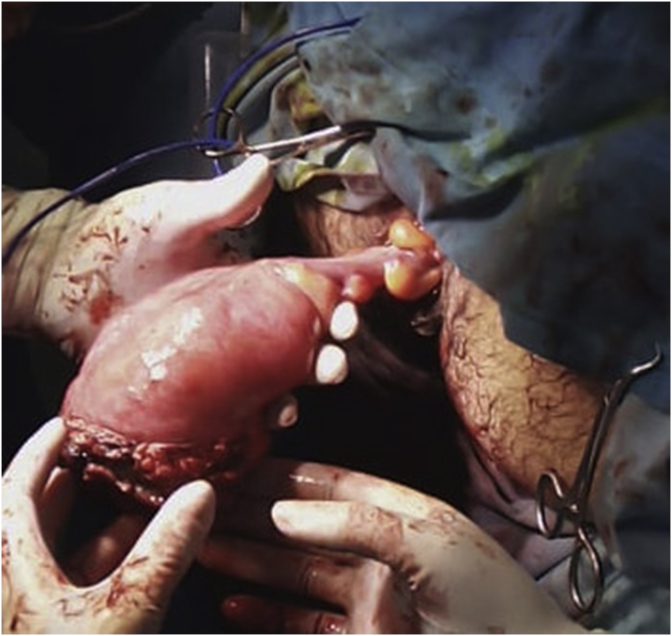
Protruded rectum.